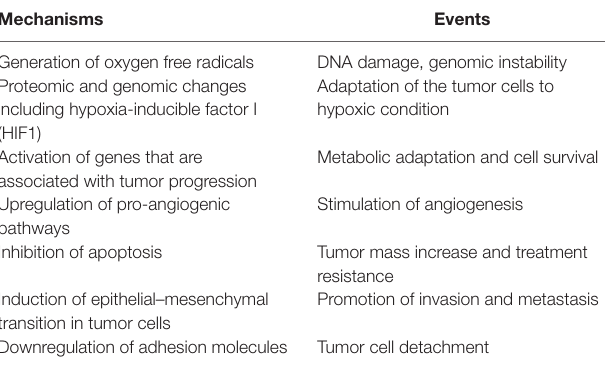
TABLE 1 | The major events led by hypoxia in tumor